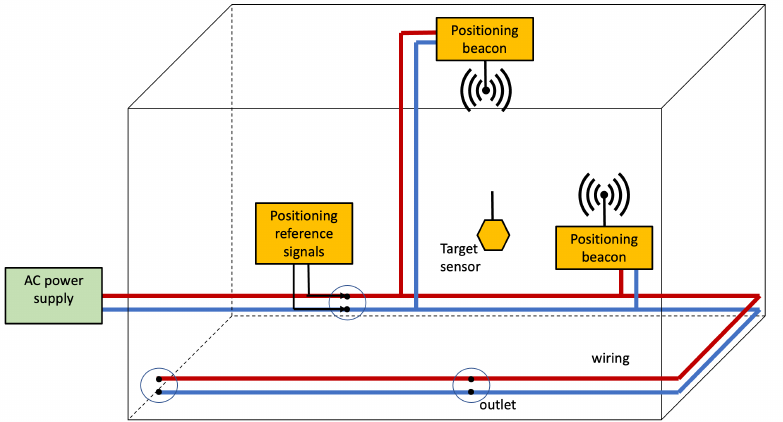
Figure 12. Infra-based and Target-based PLC-Wireless PLPS architecture. The PLPS components are highlighted in yellow. The electrical network delivers the positioning beacon to the